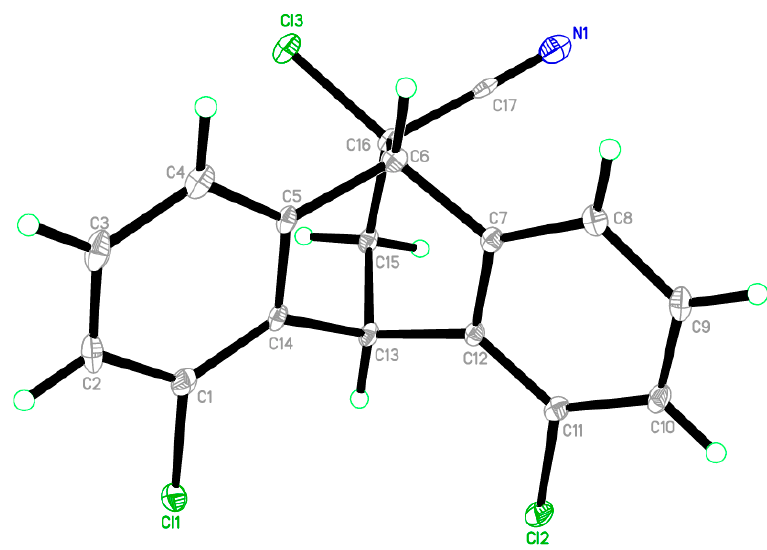
Figure 1. ORTEP drawing of isomer 1 and its numbering scheme. Thermal ellipsoids are drawn at the 40% probability level at 100 K. Table 1. Crystal structure and refinement data for isomer 1 .